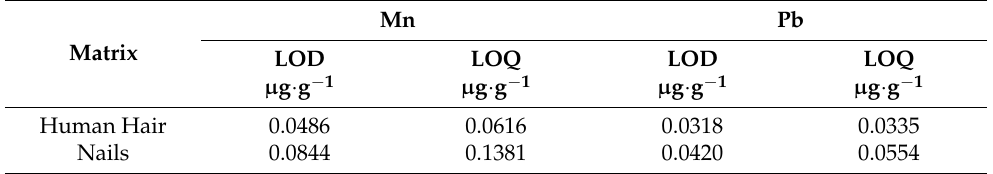
Table 7. Limit detection (LOD) and quantification (LOQ)